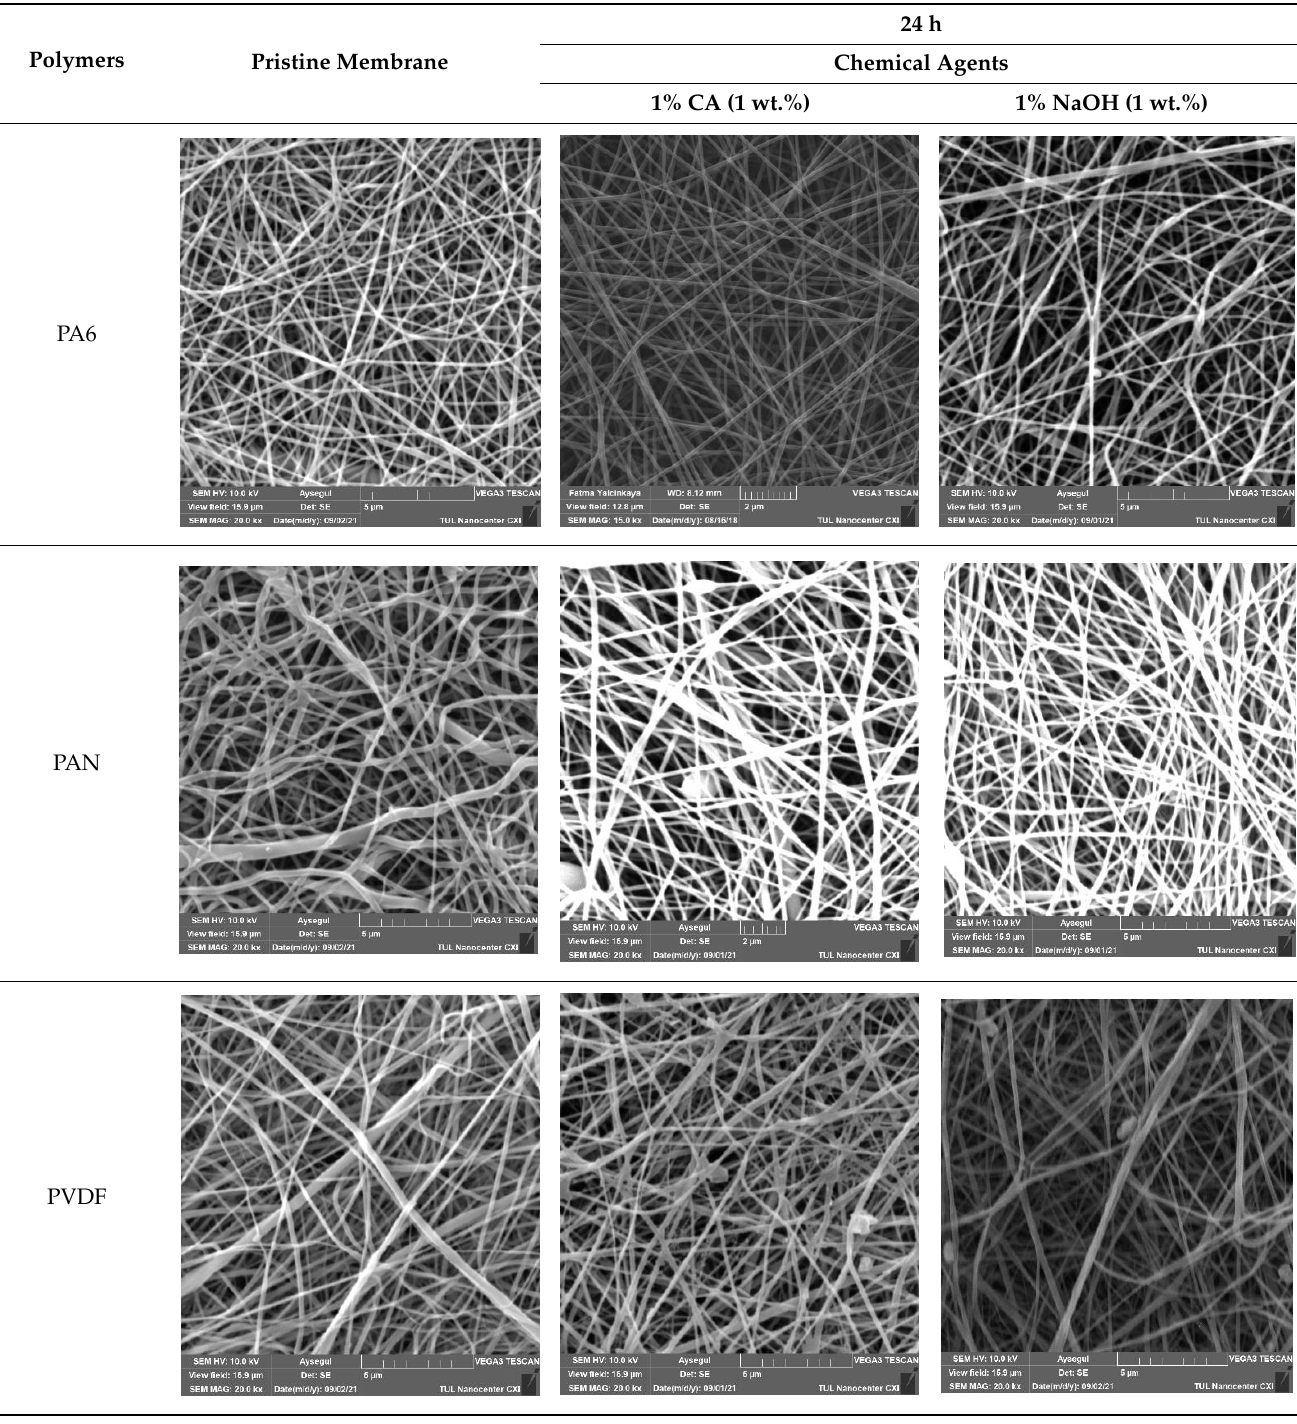
Table 5. SEM images of membranes after the application of chemical cleaning agents (1% CA-1% NaOH).